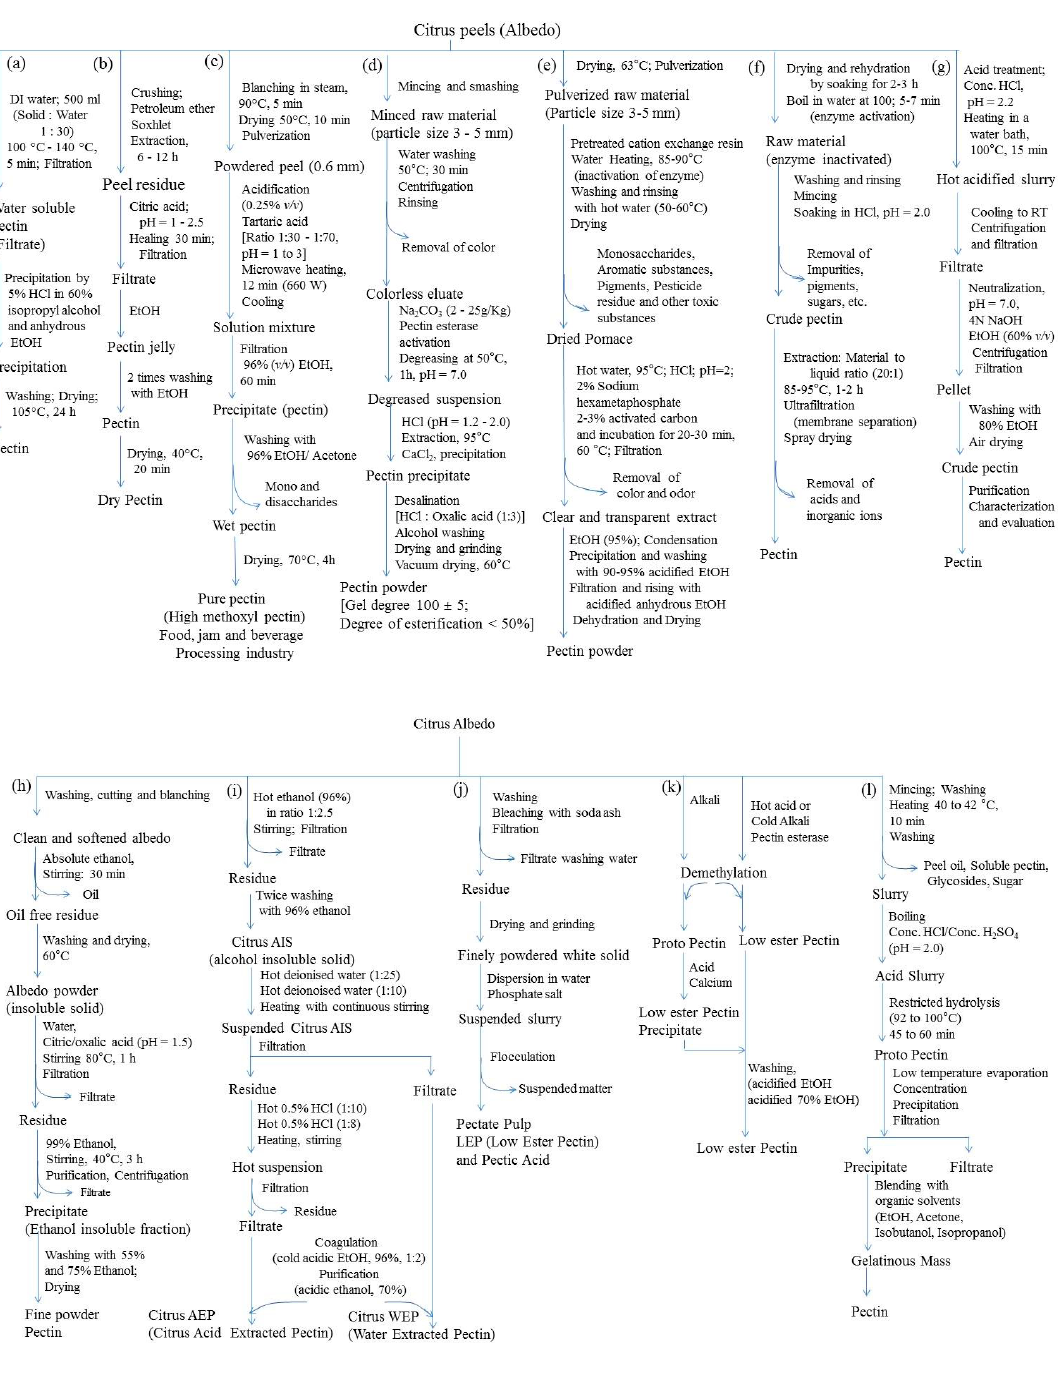
Figure 11. Steps involved in the different extraction methods for obtaining pectin from citrus waste [65,155,156]